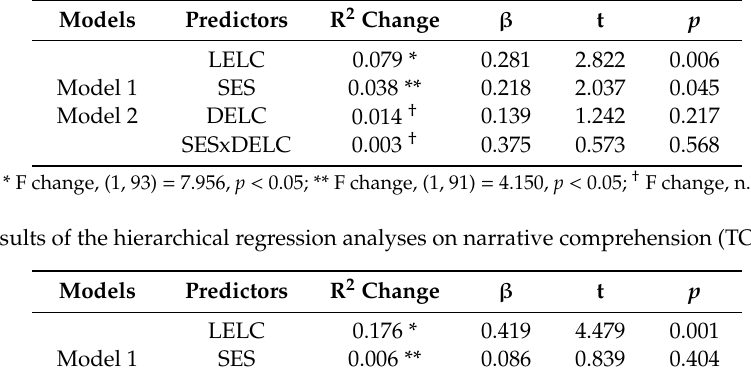
Table 6. Results of the hierarchical regression analyses on grammar comprehension (PVCL). R 2 = 0.13.